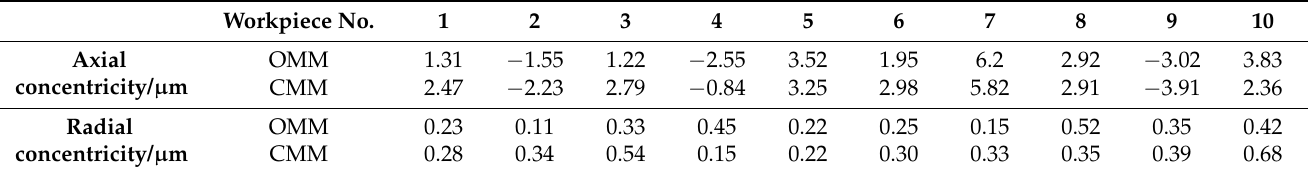
Table 1. Concentricity test results of 10